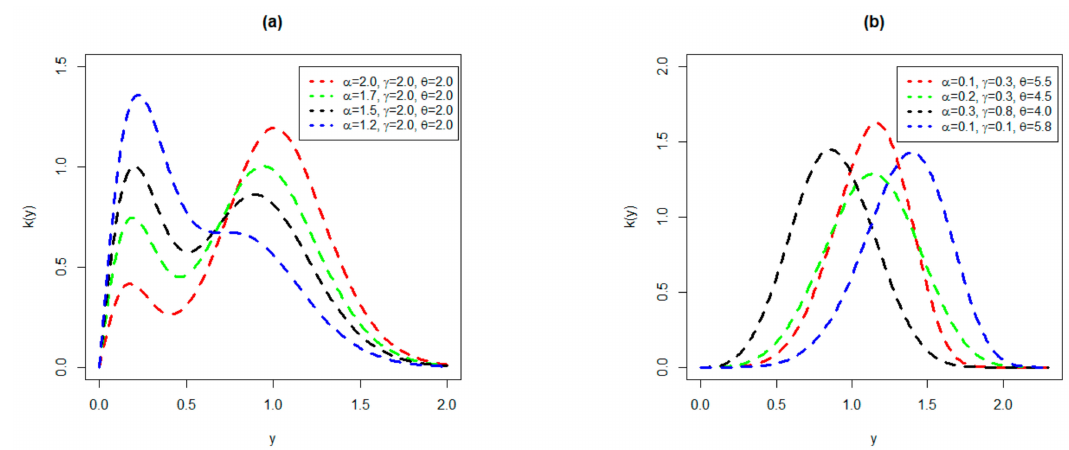
Figure 1. Plots of ( a ) bi-modal, and ( b ) left-skewed, right-skewed, and symmetrical PDF k ( y ; α , ∆ ) of the proposed NMEPA-Wei distribution.